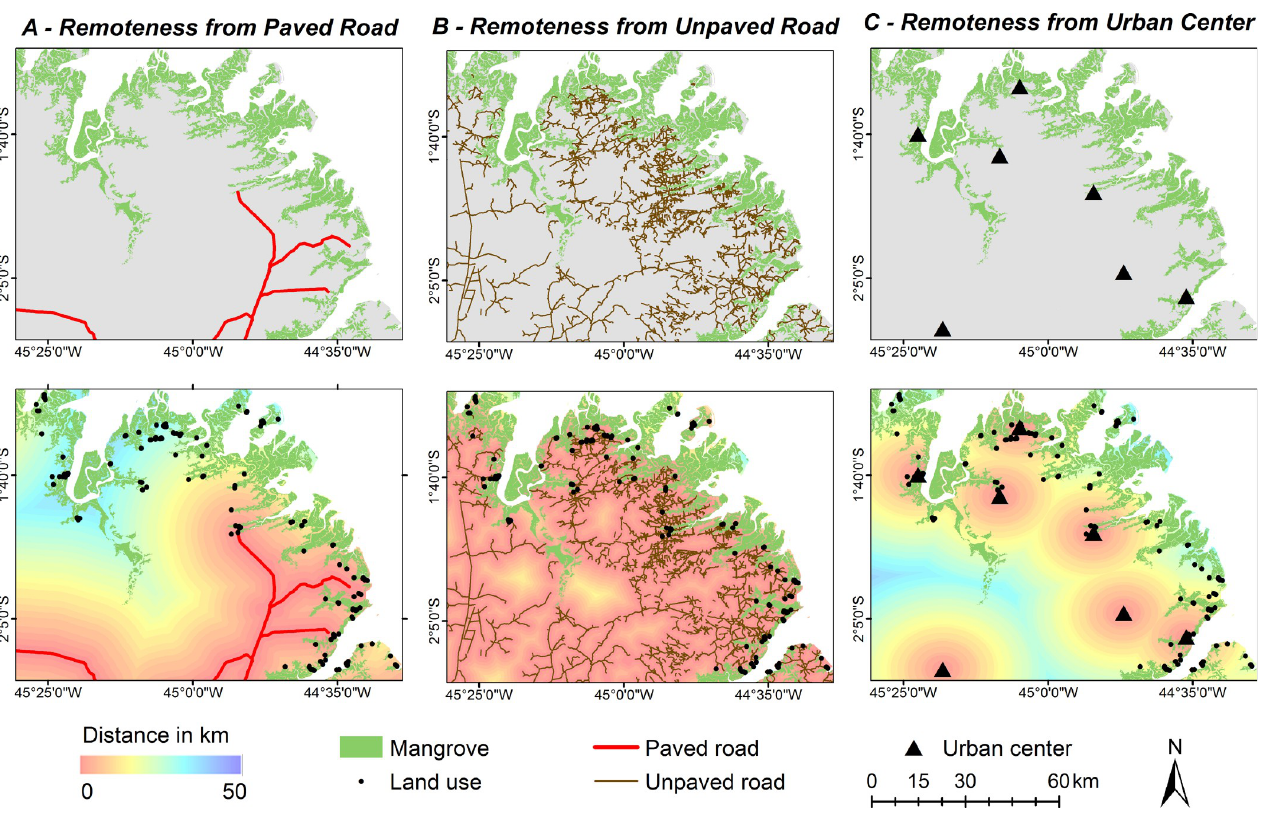
Fig 3. Distance (km) from the occurrences of land use in relation to A) paved roads (red lines), B) unpaved roads (brown lines), and C) urban centers on the Brazilian Amazon coast (black triangles).